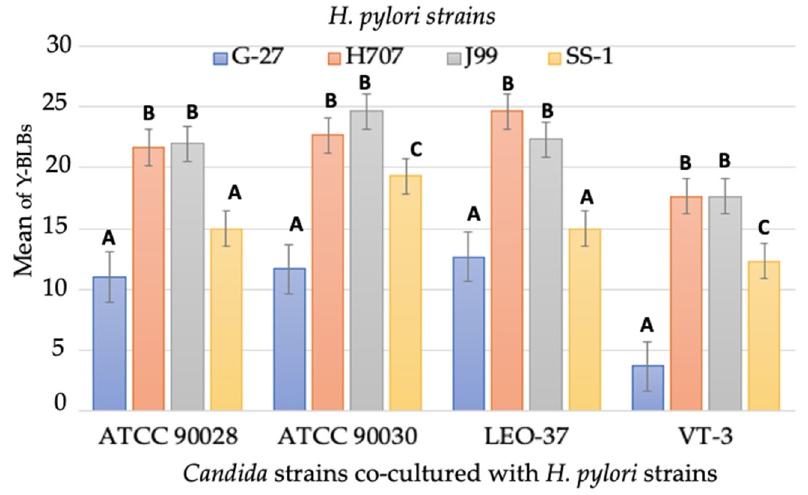
Figure 8. Mean of Y-BLBs identified in the co-cultures incubated in BB-1%FBS for 48 h. There is no significant difference in Y-BLB means when comparing co-cultures carried out with H. pylori J99 or H707 strains with all yeast strains. The higher means of Y-BLBs were obtained in the co-cultures carried out with these two strains and the two C. glabrata strains. Results are expressed as mean ± SD. Means with different letters are significantly different ( p < 0.05).